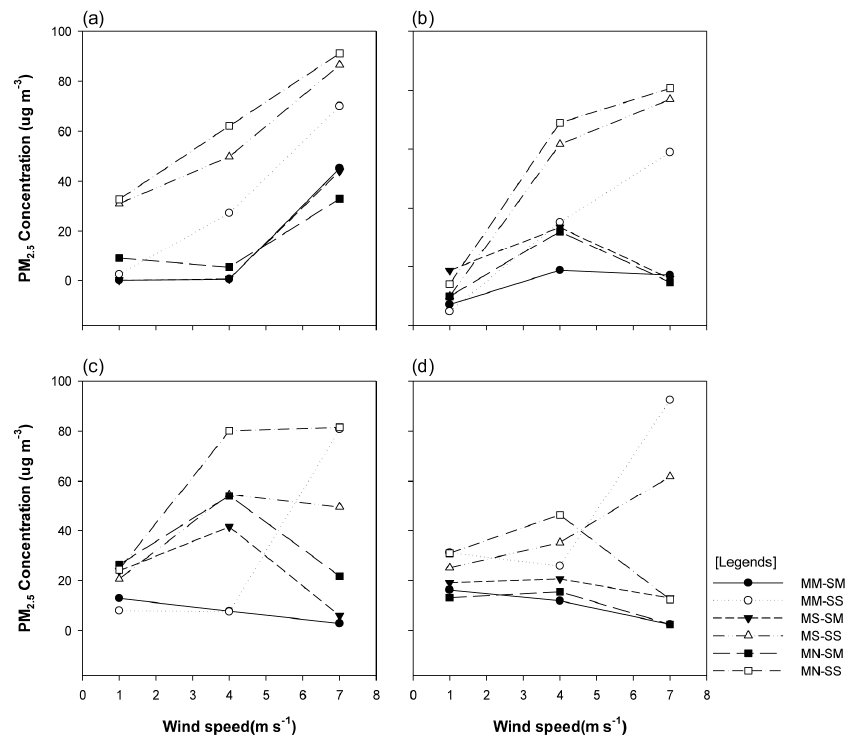
Figure 9. Graphs portraying the particulate matter (PM 2.5 ) concentration at each site, based on the changes in the wind velocity, when the wind direction was vertical (0°): ( a ) pedestrian road (P-1), changes in the wind velocity, when the wind direction was vertical (0 ◦ ): ( a ) pedestrian road (P-1), ( b ) leeward motor road (P-2), ( c ) windward motor road (P-3), and ( d ) windward pedestrian road (P-4).